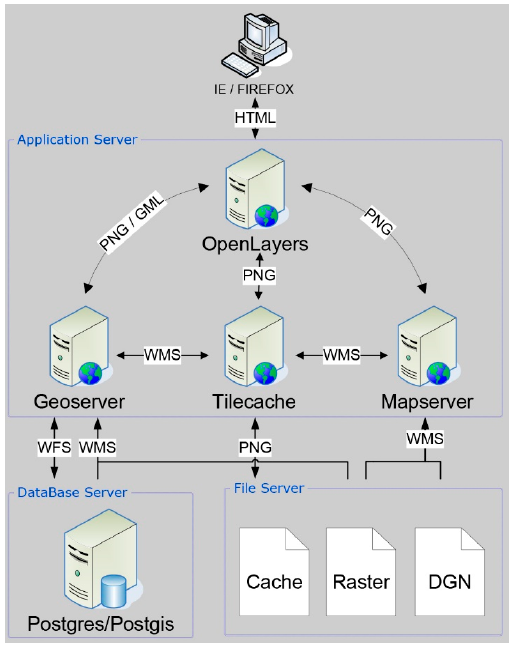
Figure 8. Potential of solar energy production on building roofs.